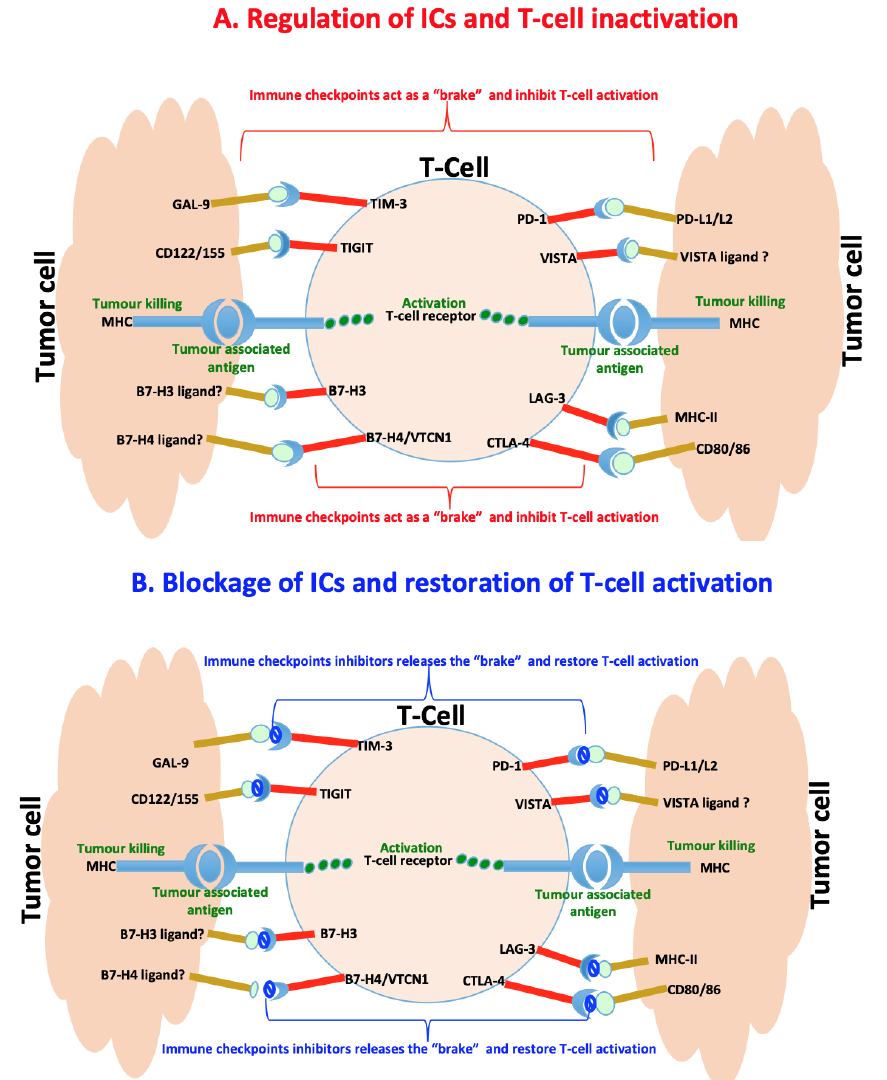
Figure 3. Immunoregulation of checkpoints in prostate cancer. ( A ) Immune checkpoints are usually hijacked during cancer and act as a “brake” upon binding to their ligands to slow down or inhibit cancer targeting T-cells and killing of tumor cells. ( B ) Counteracting the interaction of the immune checkpoints by their specific inhibitors release the “brake” and restores the T-cells functioning leading to killing of tumour cells.